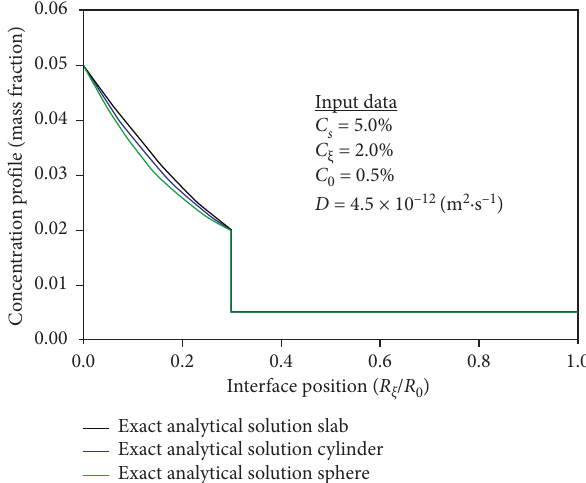
Figure 9: Comparison of concentration profiles during inward diffusion of a slab, a cylinder, and a sphere as a function of di- mensionless position ( R